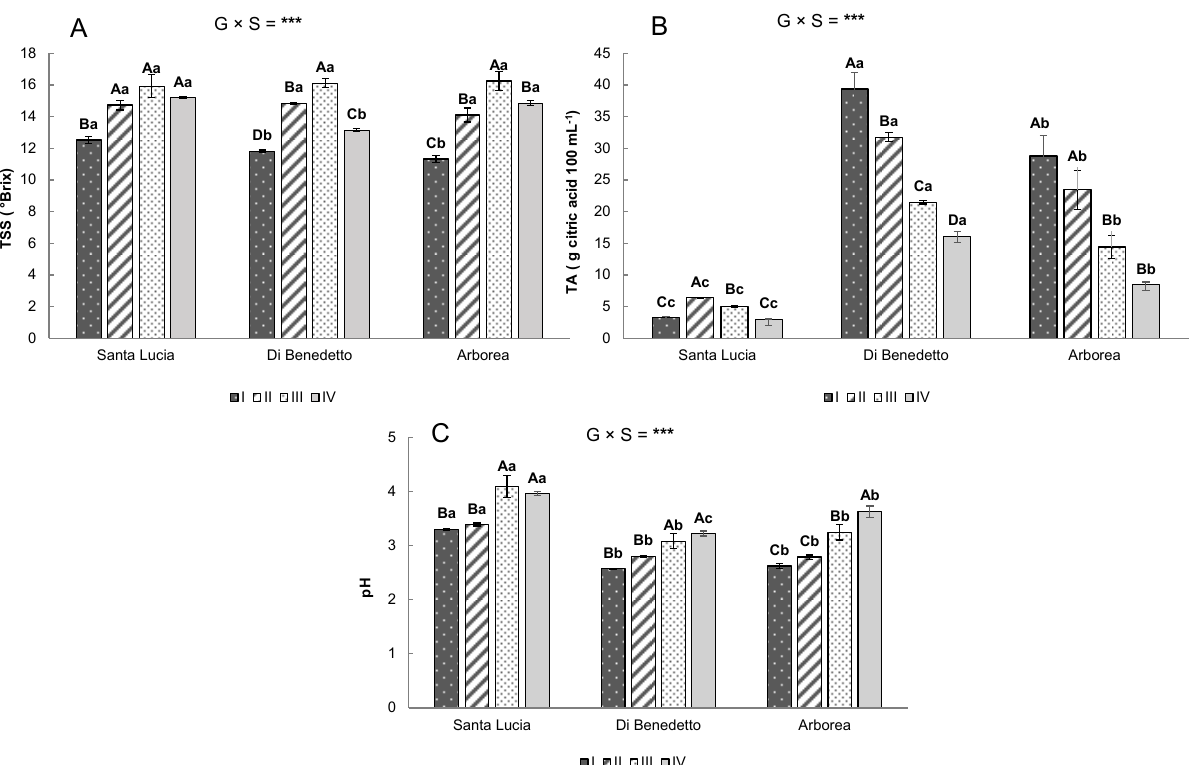
Figure 1. Total soluble solids (TSS) ( A ), titratable acidity (TA) ( B ), and pH ( C ) of three pomegranate genotypes (‘Santa Lucia’, ‘Di Benedetto’, and ‘Arborea’) during I–II–III–IV ripening stages. All the data are expressed as mean ± SE (standard error). Different uppercase letters indicate significant differences during ripening stages in the same accession, and different lowercase letters indicate significant differences in the same ripening stages for the three accessions, in accordance with Duncan’s multiple range test ( p = 0.05). Levels of significance for the two-way ANOVA (Genotype (G) × Stages (S)) are indicated as *** ( p < 0.001).